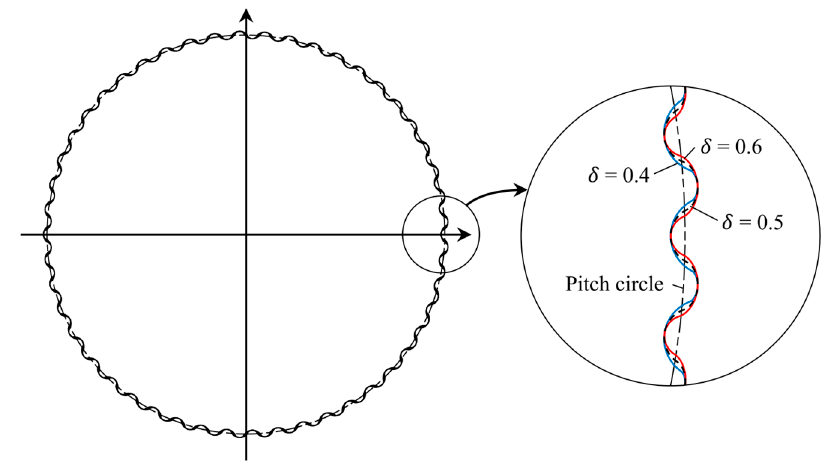
Figure 4. Cycloidal tooth pro fi les according to tooth thickness ratio.